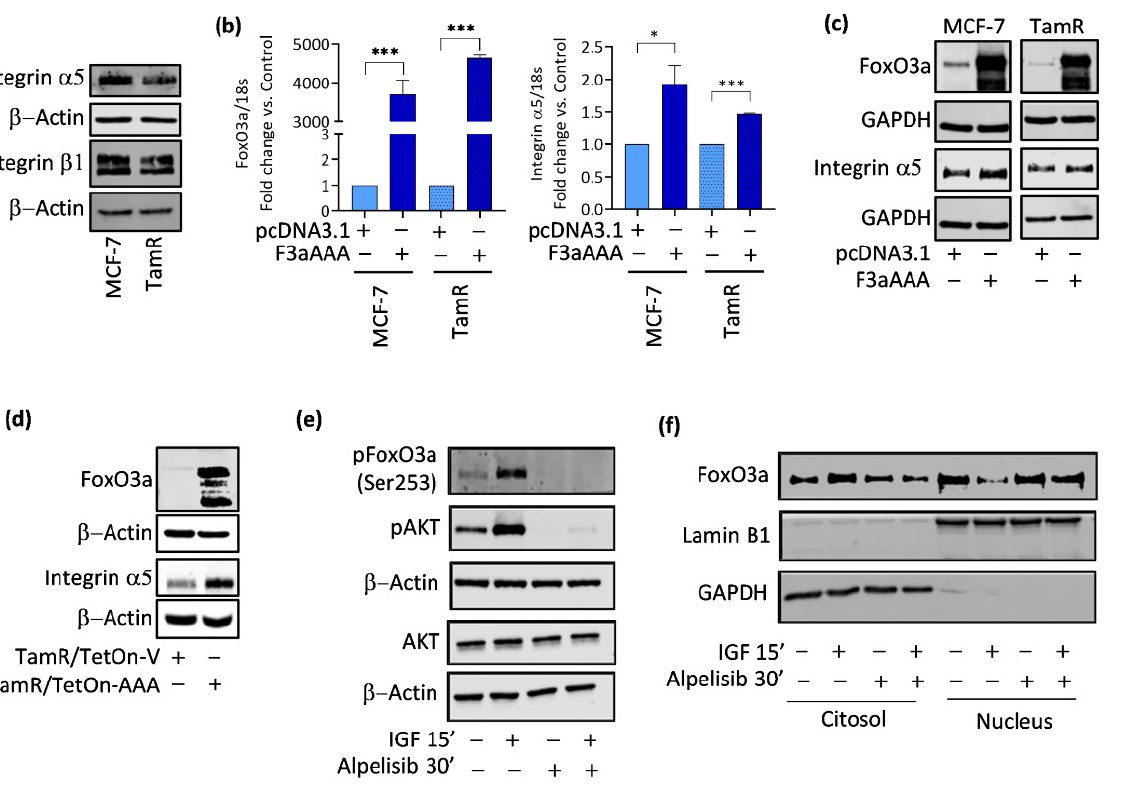
Figure 3. FoxO3a modulates integrin α 5 expression in BC. ( a ) WB analysis was conducted on 10 μ g of total lysates from TamR and MCF-7 parental cells to detect indicated proteins. β -Actin was used as a loading control. A double set of cells was transfected in suspension with F3aAAA and pcDNA3.1 plasmids for 48 h. FoxO3a and integrin α 5 expression was assessed at the ( b ) RNA and ( c ) protein level. mRNA content was normalized vs. the relative 18S rRNA content, and GAPDH was employed for loading controls. ( d ) 30 μ g of total proteins extracted from TamR/TetOn-AAA- derived tumors, explanted from Dox-treated mice, and from TamR/TetOn-V control tumors [9] were used to evaluate FoxO3a and integrin α 5 expression. β -Actin was used as a loading control. ( e ) TamR were seeded and, the day after, they were starved for 24 h, pre-treated with alpelisib 1 μ M for 30 ′ and then treated with IGF 10 ng/mL for 15 ′ . Cytosolic proteins were used to detect phosphorylated proteins. β -actin was employed as a loading control. ( f ) TamR were seeded and treated as in ( e ). Cytosolic and nuclear extracts were subjected to WB analysis for the detection of